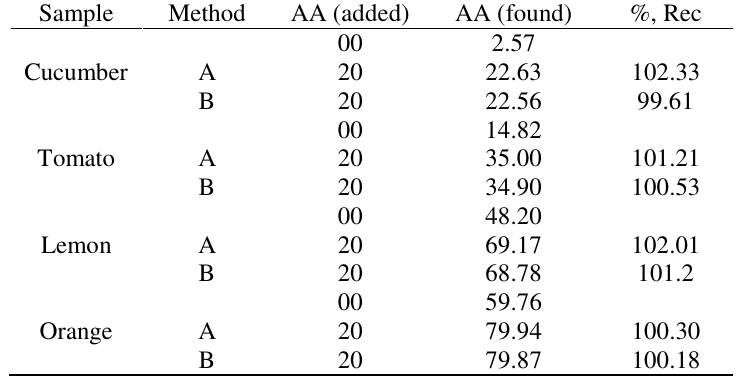
Table 3. Results of recovery test mg/ 100 g and average of five